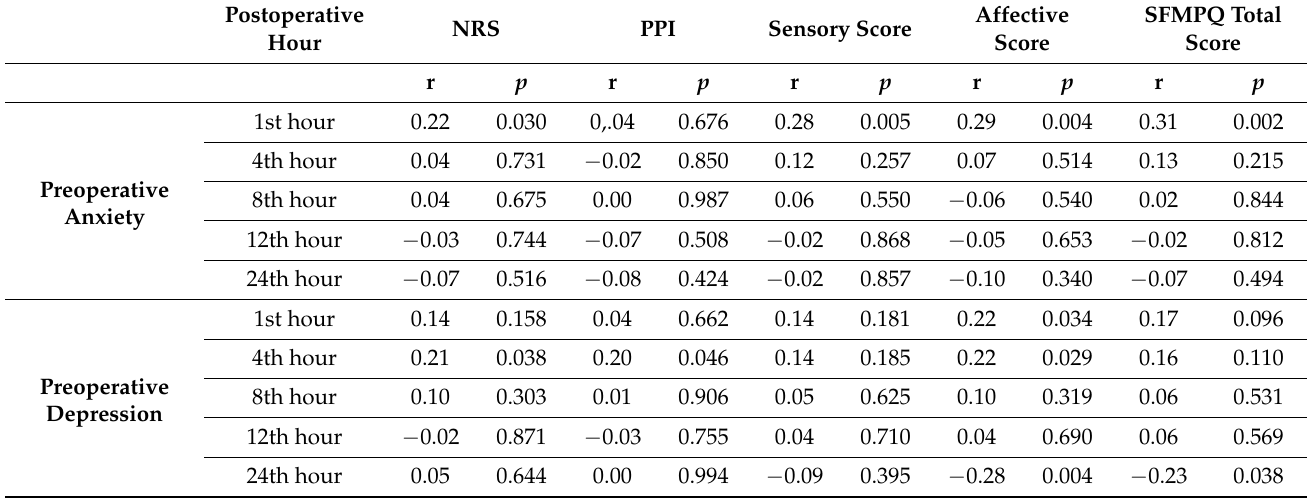
Table 6. Spearman’s correlation coefficients of the preoperative anxiety and depression scores with the MPQ-SF parameters for every predetermined time